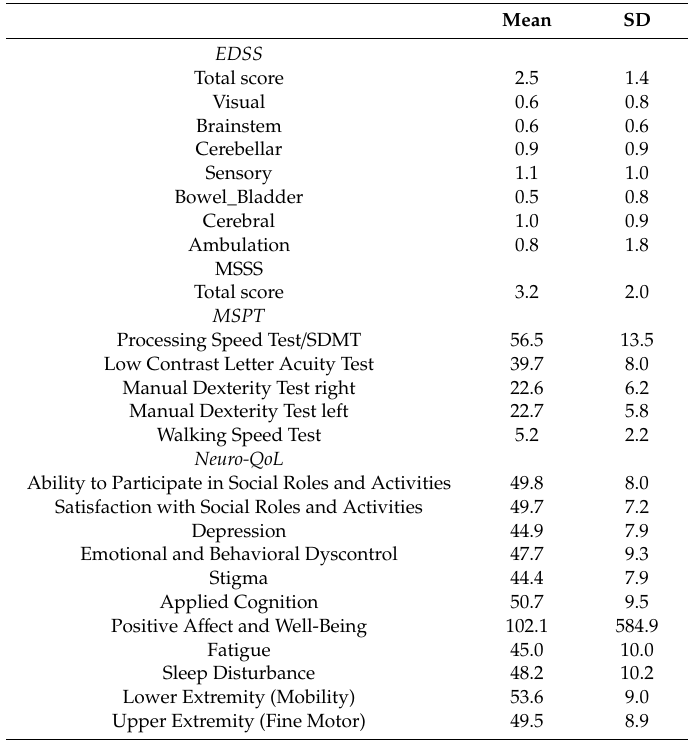
Table 1. Expanded Disability Status Scale (EDSS), Multiple Sclerosis Severity Score (MSSS) and Multiple Sclerosis Performance Test (MSPT) scores. The mean and standard deviation (SD) are